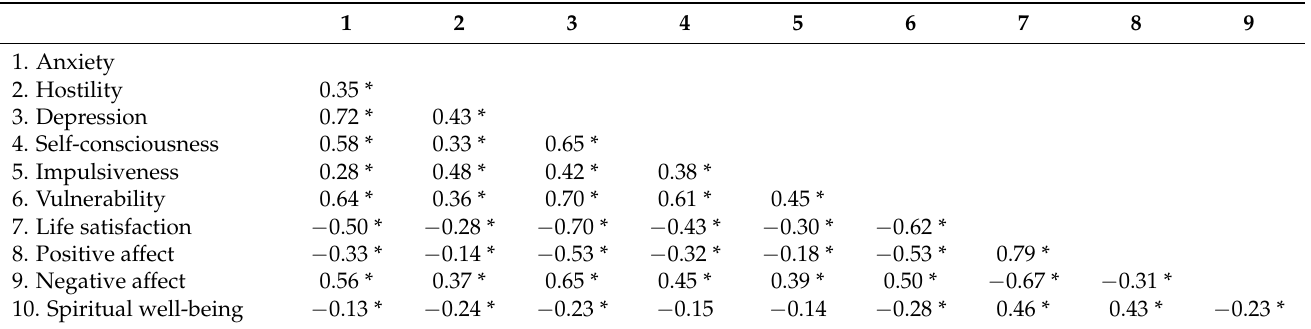
Table 2. Correlations among variables.